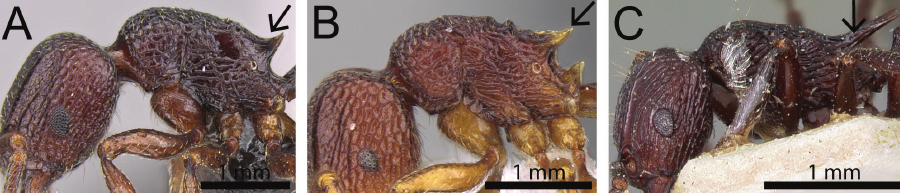
Figure 12. Posterior head and mesosoma in profile (black arrows indicate propodeal spines/teeth. A T. fhg-ants (CASENT0248302) B T . fhg-anub (CASENT0404158) C T. latreillei